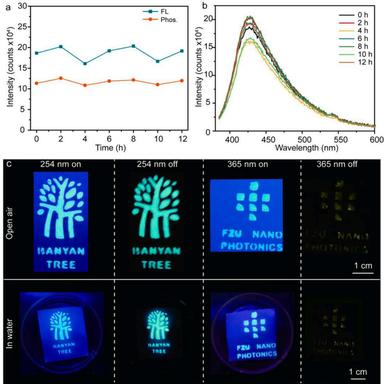
(a) Changes of phosphorescence and fluorescence intensity of CDs@SiO2 composite material under UV irradiation for up to 12 h, (b) fluorescence emission spectra of different UV exposure time, and (c) the photographs of CDs@SiO2 based security labels in the open air (row: 1), in water (row: 2).